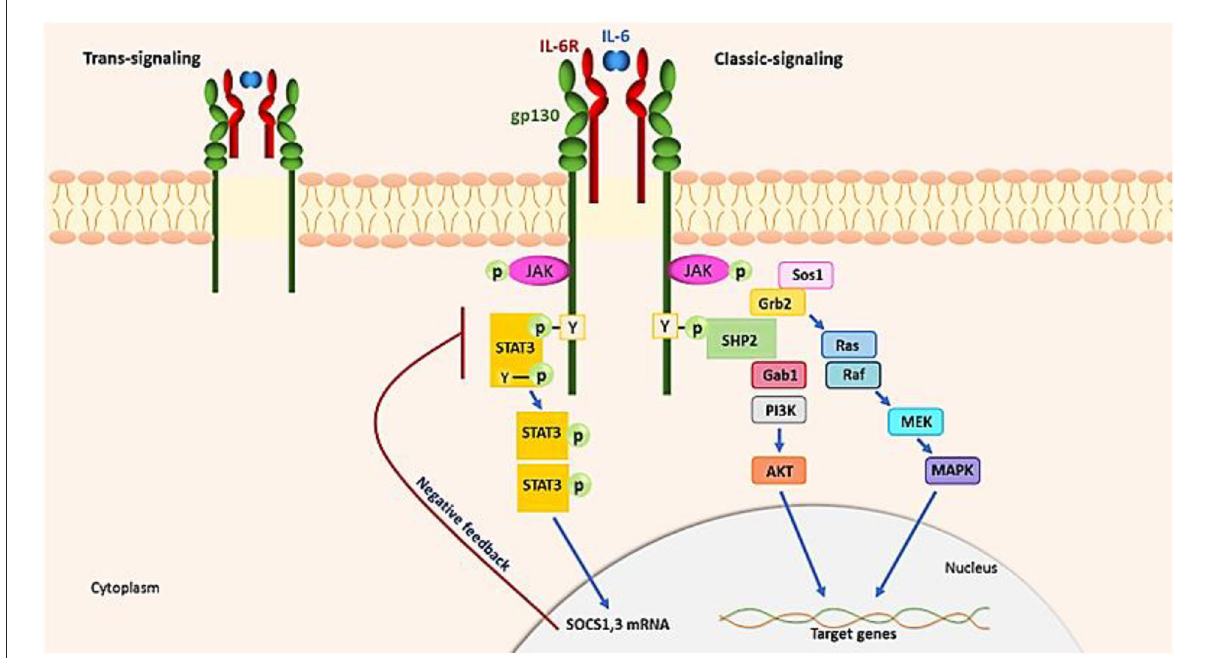
FIGURE4 IL-6 signaling pathways. IL-6 requires two receptors, the IL-6R and the gp130, to begin signaling. IL-6 (classic signaling) binds to either fluid- or membrane-bound IL-6R (SIL-6R, trans-signaling). In two modalities of IL-6R signaling, a hexamer complex with gp130 is formed.